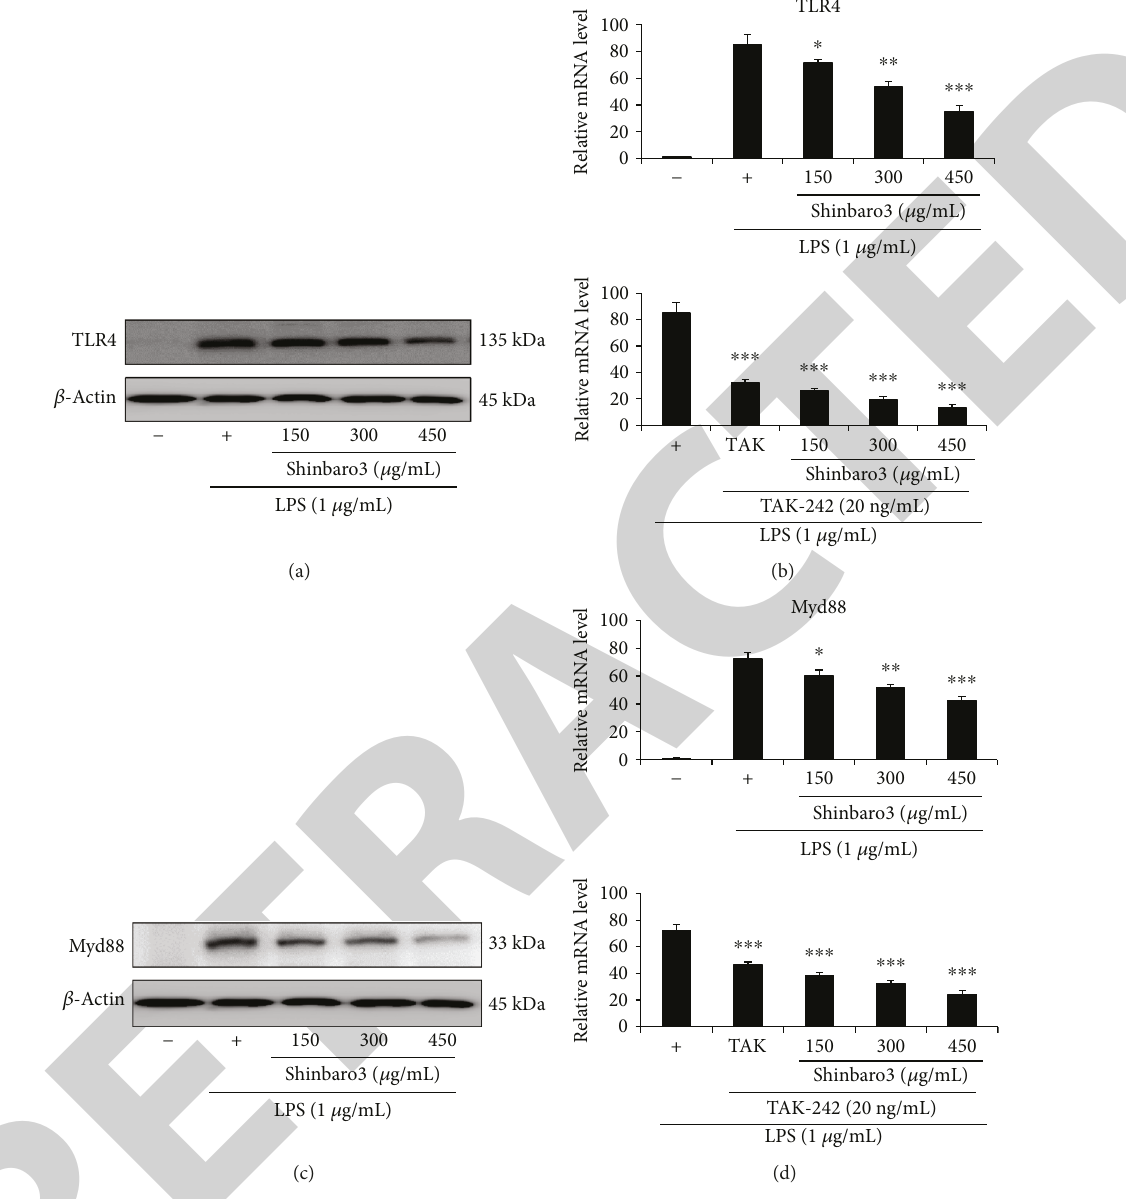
Figure 7: E ff ects of Shinbaro3 on the TLR4/Myd88 signalling pathway in LPS-stimulated RAW 264.7 cells. RAW 264.7 cells were treated with LPS (1 μ g/mL) and Shinbaro3 (150, 300, and 450 μ g/mL) for 6 h. (a, b) TLR4 and (c, d) Myd88 protein and mRNA expression levels were analysed via Western blotting and real-time RT-PCR, respectively. The results were normalized using β -actin as an internal control. The data are presented as the mean ± SD ( n = 3 ). ∗ p < 0 05 , ∗∗ p < 0 01 , and ∗∗∗ p < 0 001 versus LPS treatment